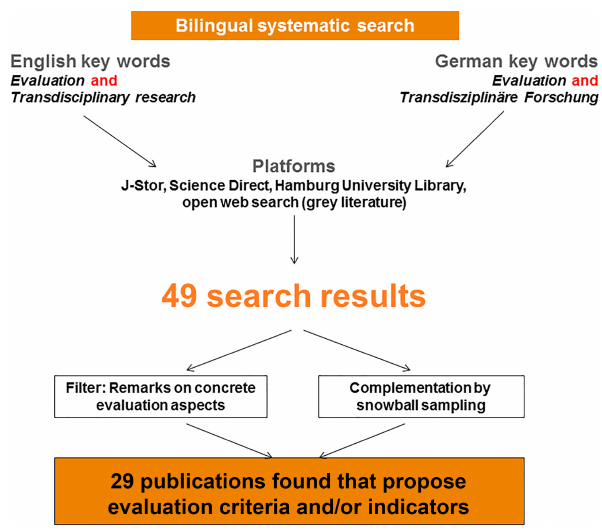
Figure 1. Search method for literature overview in the field of trans- disciplinary